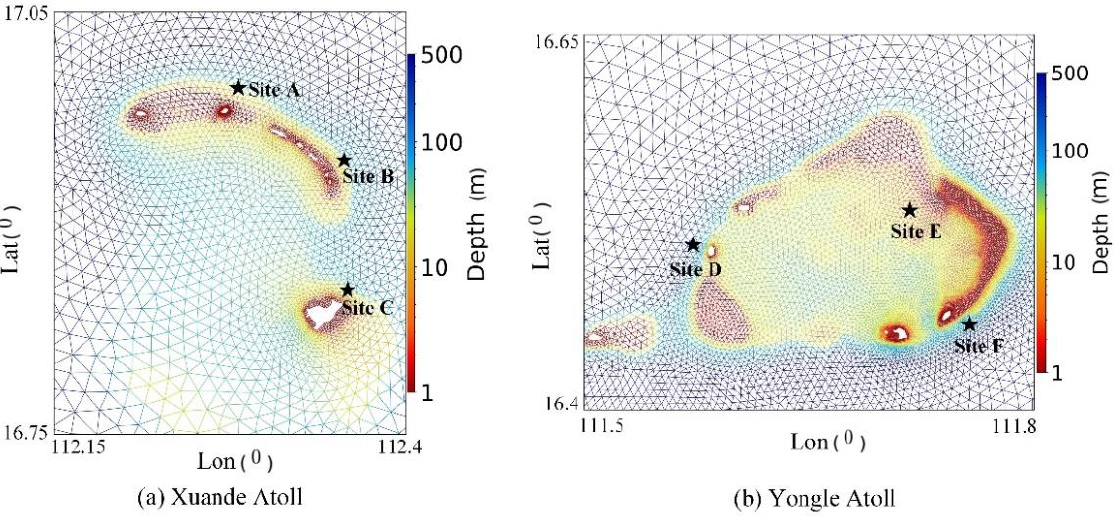
Figure 12. Monthly wind rose plots of wind speed at the Xisha Islands.